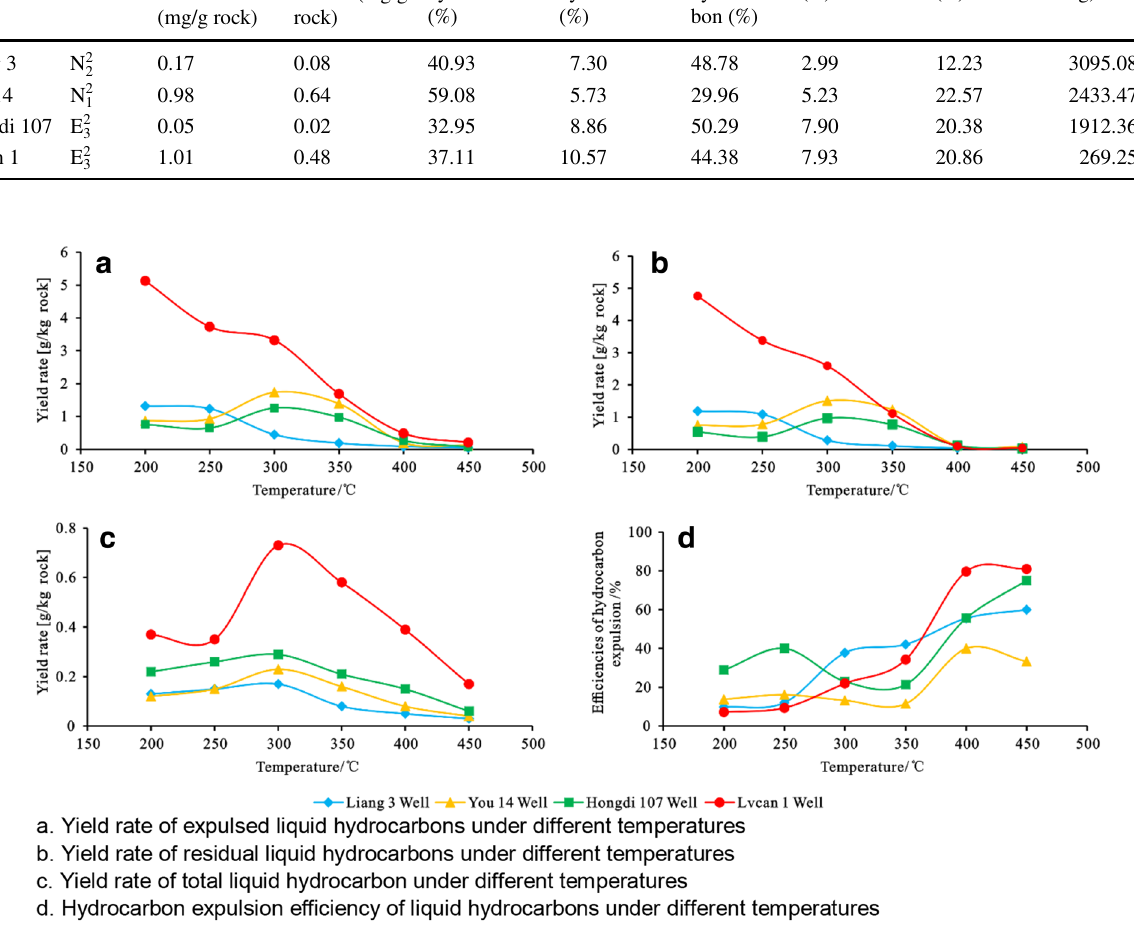
Table 2 Analytical data of soluble components of Paleogene–Neogene-simulated samples in the Western Qaidam Basin Well